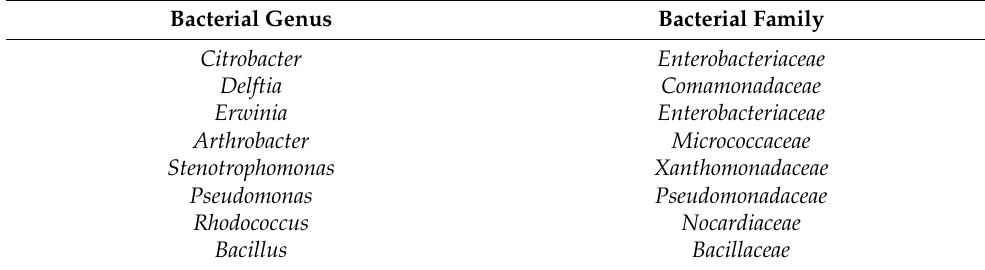
OTUs conserved across all slug samples (Table 1), which is consistent with our second hypothesis, that a core bacterial microbiome is present and not changed due to experi- mental perturbations. While some bacterial taxa were shared across all treatments, both sterility ( p < 0.015) and environment ( p < 0.007) explained the variation among the total slug bacterial microbiomes. Table 1. The Core Bacterial Microbiome—taxa present in all Ambigolimax valentianus